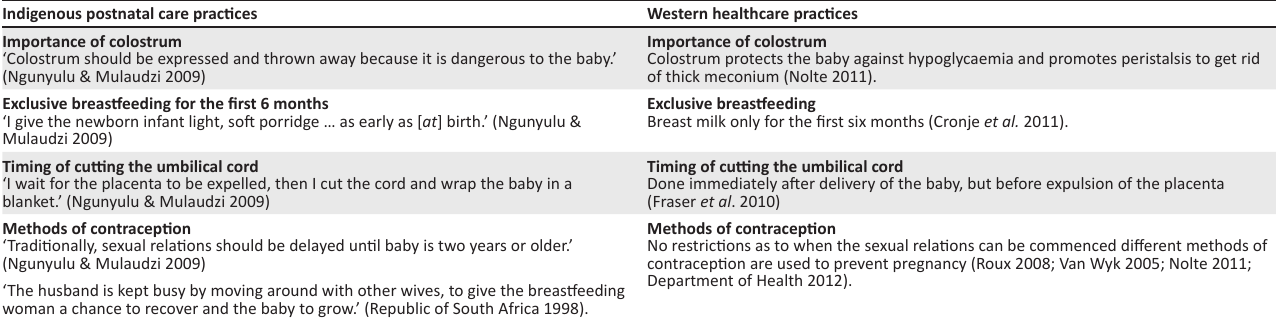
TABLE 2: Differences between indigenous and Western postnatal care practices. Indigenous postnatal care practices Western healthcare